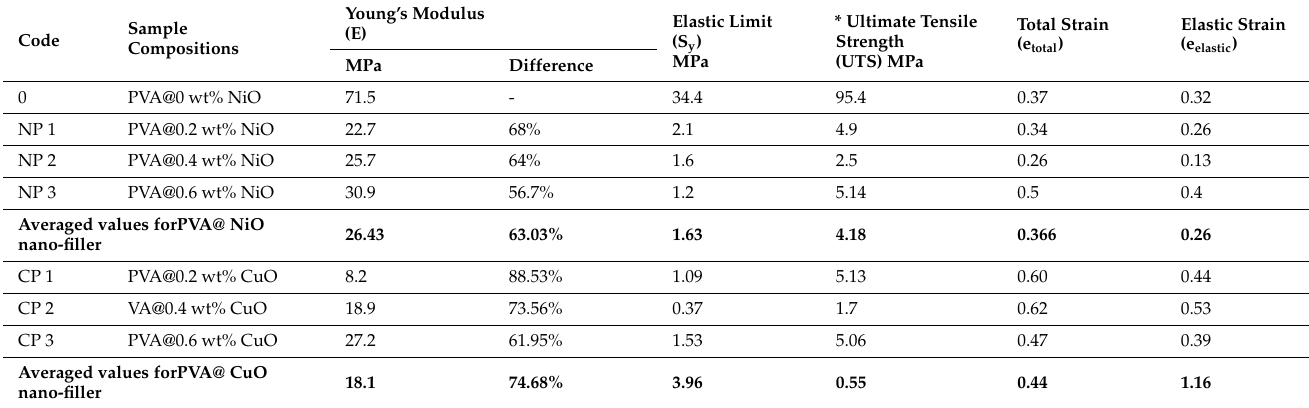
Table 3. Mechanical properties of PVA and nanocomposite thin